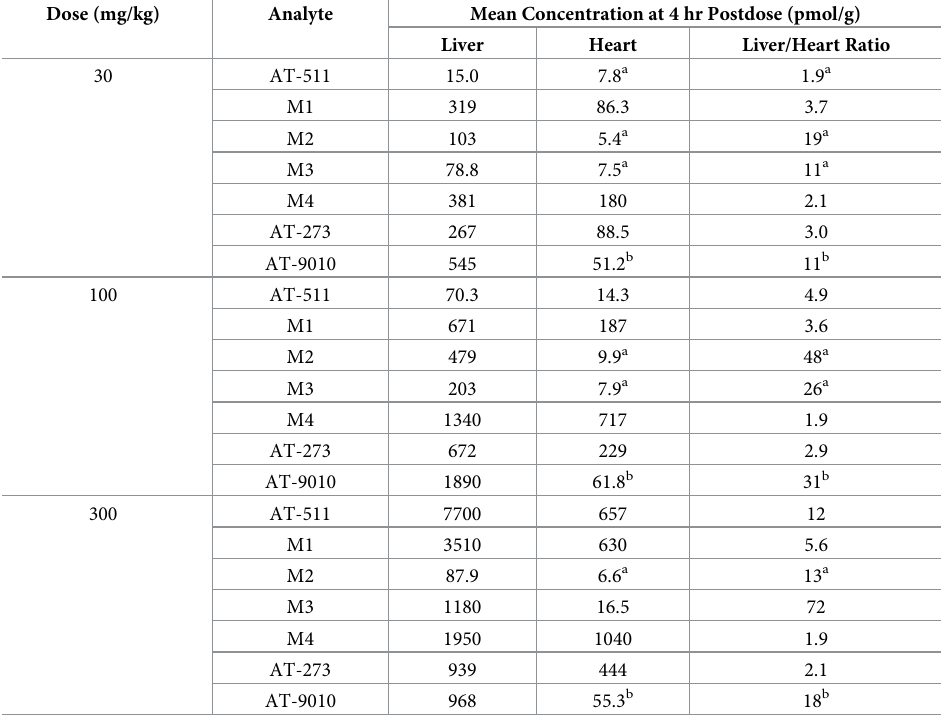
a Means of heart concentrations contain values estimated by extrapolation of the calibration curve below the LLOQ (10–20 pmol/g) for all analytes except AT-9010 b Individual heart concentrations of AT-9010 were estimated by extrapolation of the calibration curve below the LLOQ of 110